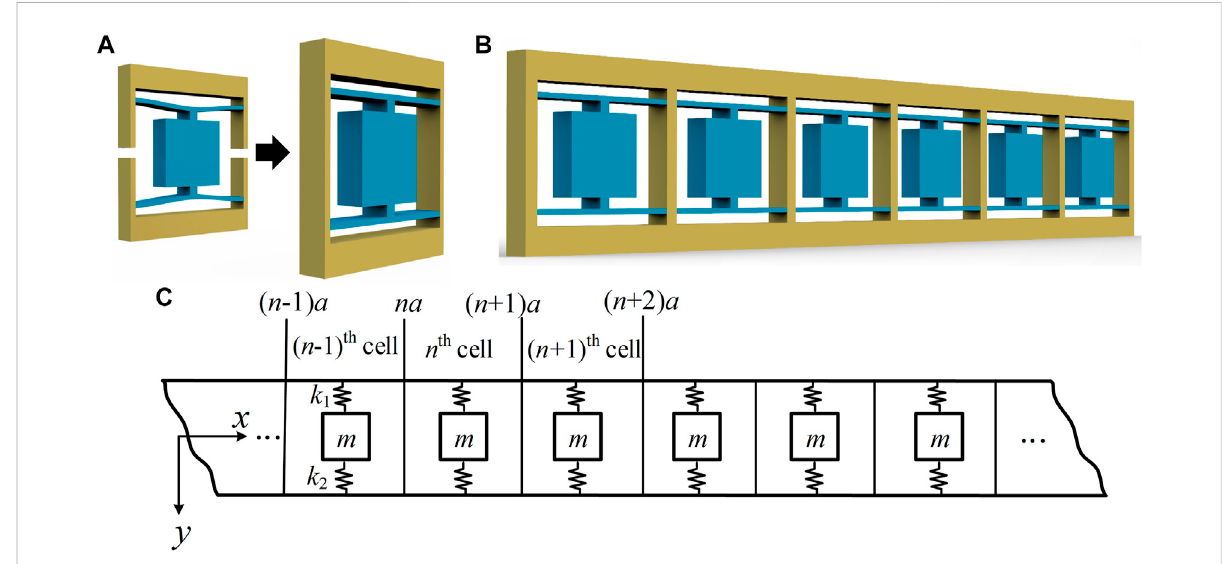
FIGURE 8 The QZS-LR metamaterial. (A) The embedded QZS-LR metastructure model. (B) The QZS-LR metamaterial model. (C) A simple model of the QZS-LR metamaterial.